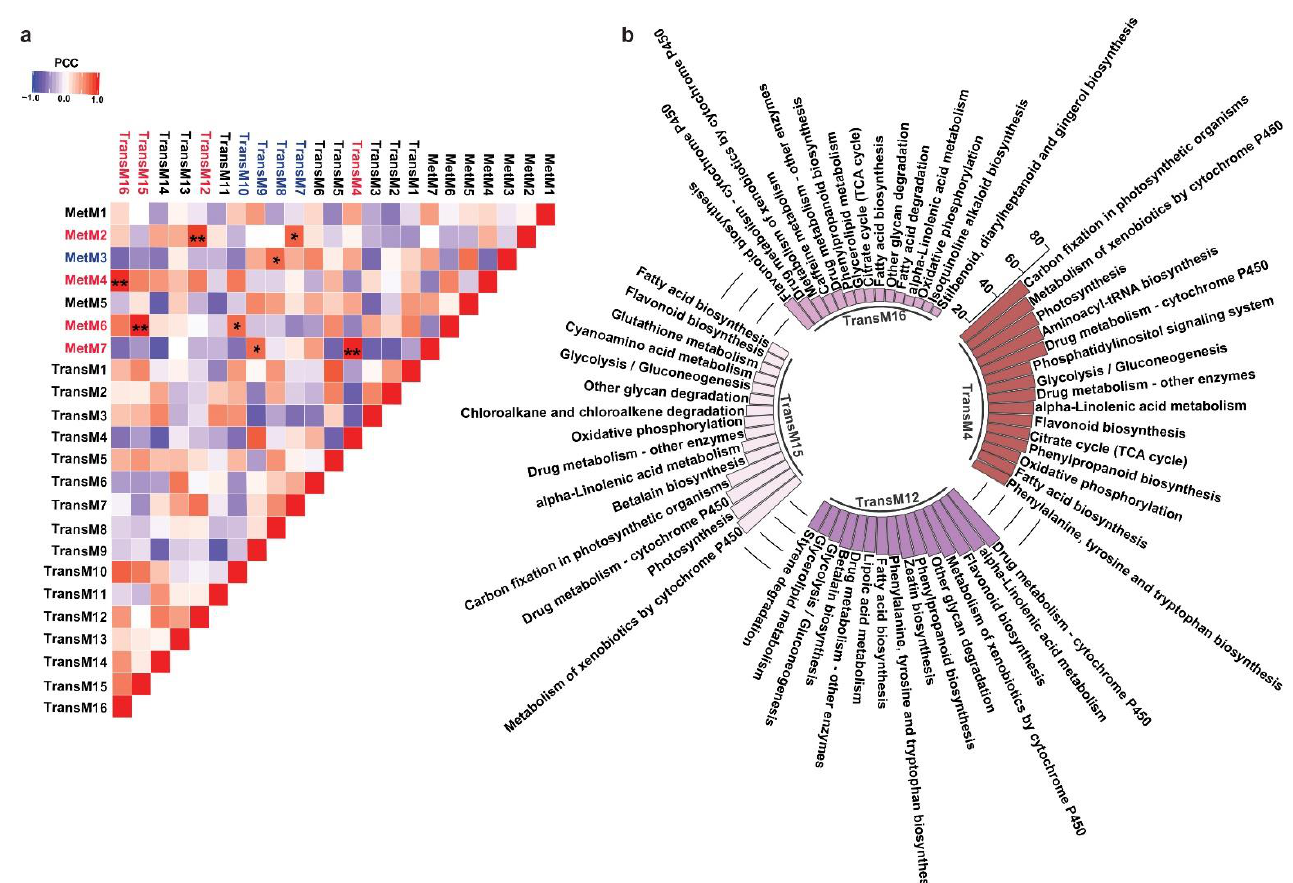
Figure 6. Integrated analysis of transcript and metabolite modules. ( a ) Pearson correlation coefficient between each pair of TransM and MetM module. The red font represents transcript-metabolite modules with over 0.9 correlation, while the blue font represents transcript-metabolite modules with over 0.7 correlation. ** pairs with PCC > 0.9, * PCC > 0.7; ( b ) Top 15 KEGG pathways based on the percentage of specific pathways represented by transcripts co-clustered in TransM4, TransM12, TransM15, and TransM16, the four modules with high correlation with metabolite module.